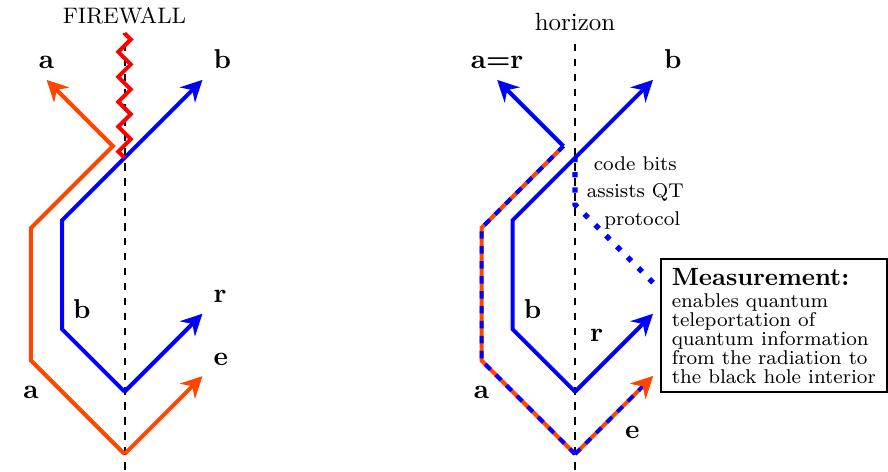
Figure 3. Schematic depiction of the firewall argument and its proposed resolution via a quantum teleportation protocol. Left: quanta e and r escape the black hole thanks to entanglement with Hawking partners a and b . After the Page time, when the black hole is in a maximally mixed state, a and b can not escape via the usual Hawking process: when b leaves, it can not be entangled with any interior mode a . The horizon turns into a firewall. Right: as Hawking quanta propagate through space-time, they entangle with their environment, they decohere and produce classical information encoded in the soft hair degrees of freedom. The classical information gets causally dispersed in the form of ‘code bits’ that specify the code subspace. The Hawking partner b can escape the black hole via the usual Hawking process, with help from a quantum teleportation protocol enabled by the code